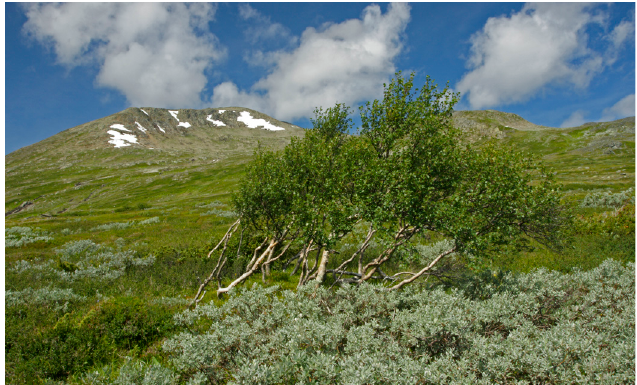
Figure 16: Stem clustering facilitates survival, growth and reproduction at the treeline. In the present case, a founder tree became established between 1910 and 1920. It has been followed by further recruitment during subsequent decades (Kullman 2007a). Mt. Storsnasen 970 m a.s.l. 18 July 2009.